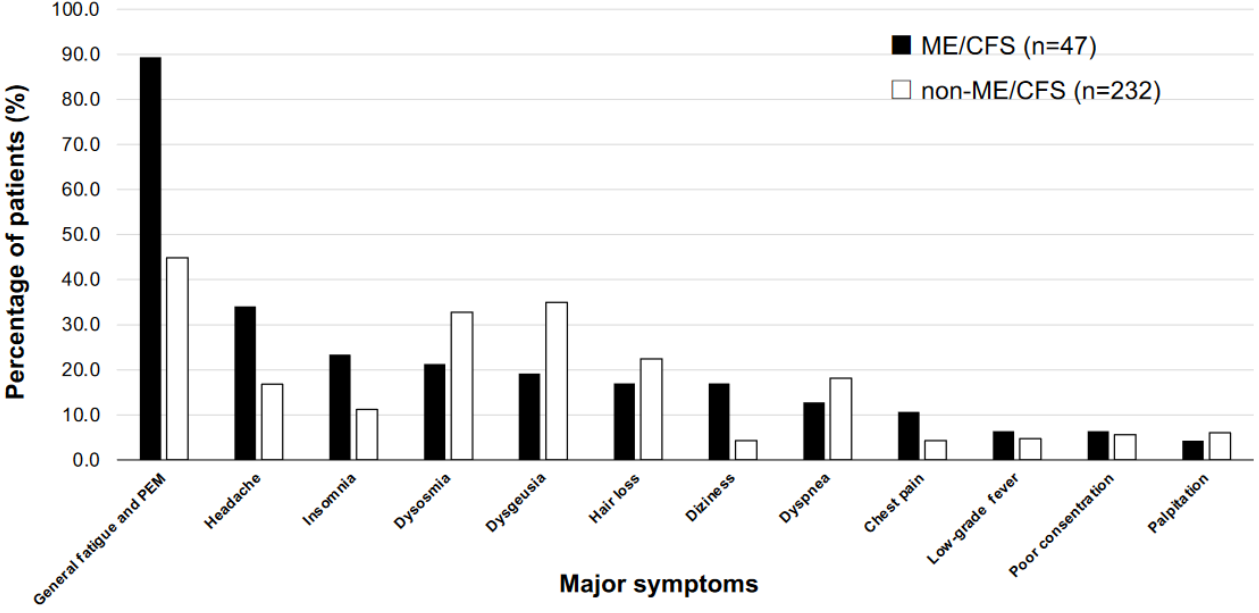
The vital signs at the first visit in the ME/CFS patients and non-ME/CFS patients were not notably different (Table 3). The patient-reported questionnaires showed significantly higher FAS, significantly lower EQ-ED, significantly lower EQ-VAS and significantly higher SDS in the ME/CFS patients (Table 3). The percentages of symptoms in the ME/CFS patients and non-ME/CFS patients (ME/CFS: n = 47, non-ME/CFS: n = 232) are shown in Figure 1. The most frequent symptoms in ME/CFS patients were general fatigue and PEM (42 patients, 89.4%), headache (16 patients, 34.0%), insomnia (11 patients, 23.4%), dysos- mia (10 patients, 21.3%) and dysgeusia (9 patients, 19.1%). On the other hand, the most frequent symptoms in non-ME/CFS patients were general fatigue and PEM (104 patients, 44.8%), dysgeusia (81 patients, 34.9%), dysosmia (76 patients, 32.8%) hair loss (52 patients, 22.4%) and dyspnea (42 patients, 18.1%).